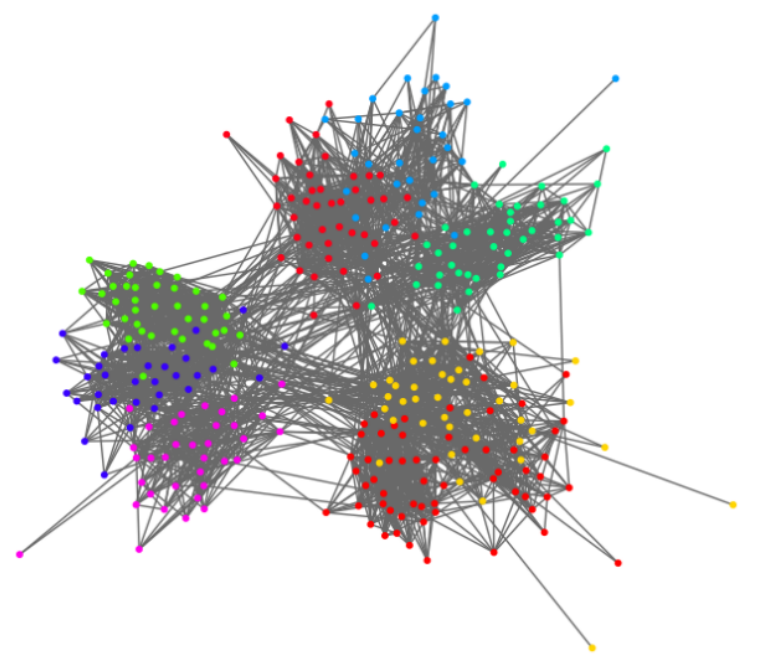
Figure 7. The community discovery visualization of the Students dataset based on the Louvian